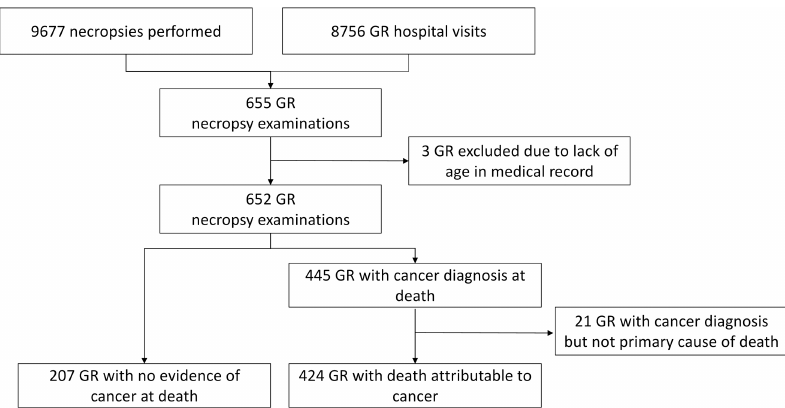
Fig 1. Study schema. Study schema showing cases included from 1989–2016 from an academic teaching hospital. GR = golden retriever